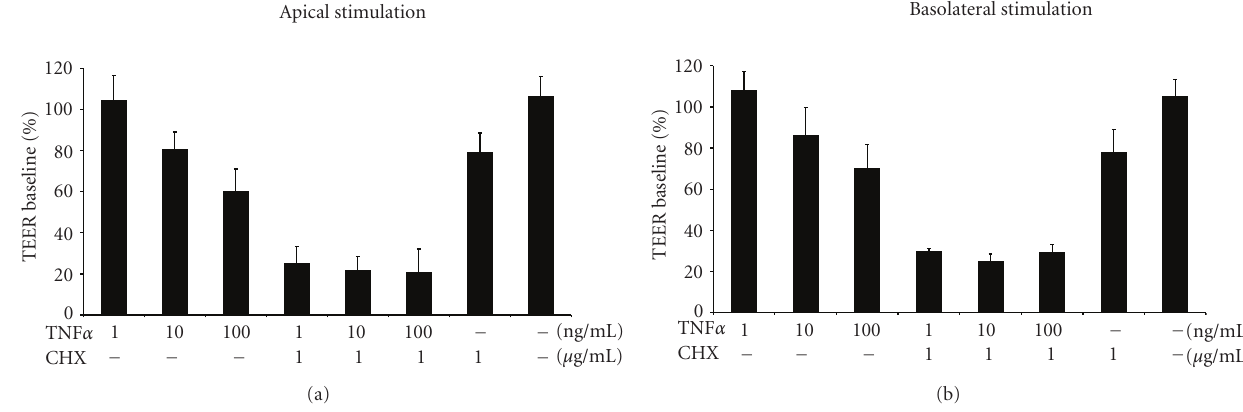
Figure 1: Apical and basolateral TNF α stimulations induce an equal e ff ect on PCPEC barrier function. PCPECs grown on Transwell filters were stimulated apically (a) or basolaterally (b) with di ff erent doses of TNF α (1, 10, 100 ng/mL) with or without the protein synthesis inhibitor cycloheximide (1 μ g/mL). E ff ects on barrier function by measuring Transepithelial electrical resistance (TEER) were determined at 24 hours. The TEER results are expressed as a percentage of baseline. The data shown are mean ± SEM of four independent experiments, each performed in duplicate.